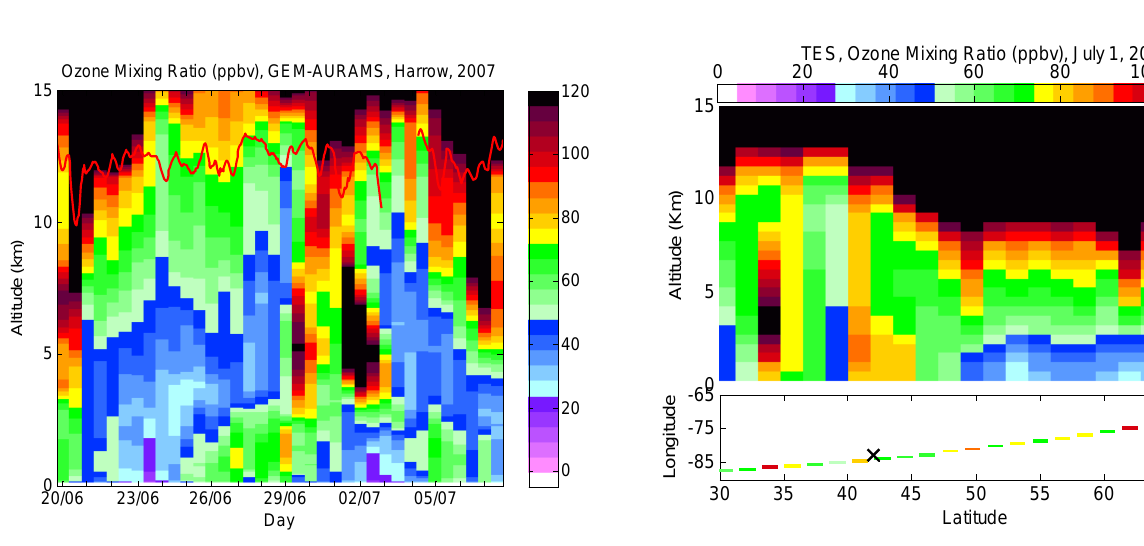
Figure 7: Upper panel: vertical profiles of TES ozone mixing ratio (ppbv) along a global survey Fig. 7. Upper panel: vertical profiles of TES ozone mixing ratio track (shown in the lower plot), on 1 July 2007. Lower panel: TES ozone mixing ratio (ppbv) at (ppbv) along a global survey track (shown in the lower plot), on 1 6 km a.s.l.. The black cross shows the location of Harrow. July 2007. Lower panel: TES ozone mixing ratio (ppbv) at 6km a.s.l. The black cross shows the location of